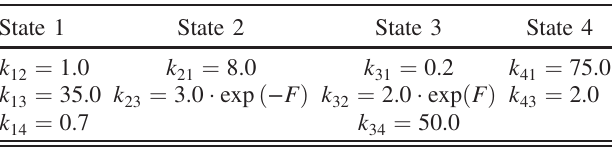
TABLE IV. Transition rates for the two-cycle network in Fig. 4. F is a dimensionless force applied to the observable link between states 2 and